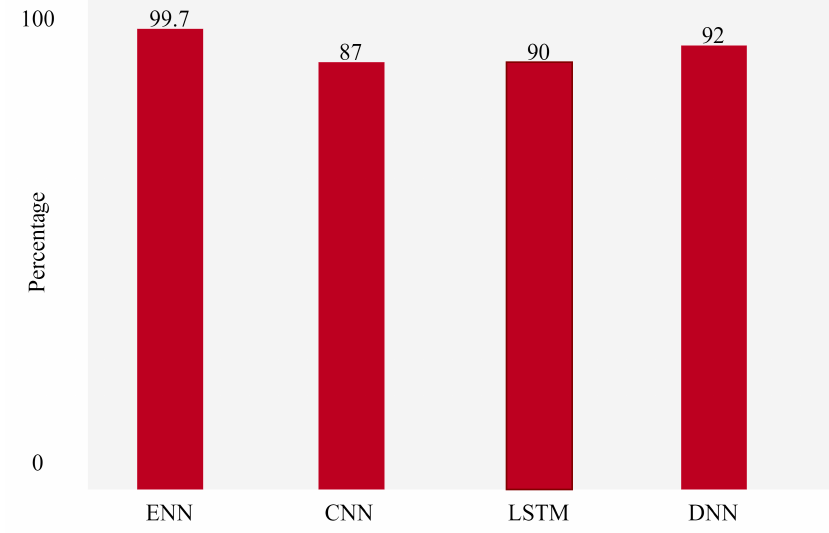
Figure 9. Accuracy of Deep Learning Models on Dataset 1.